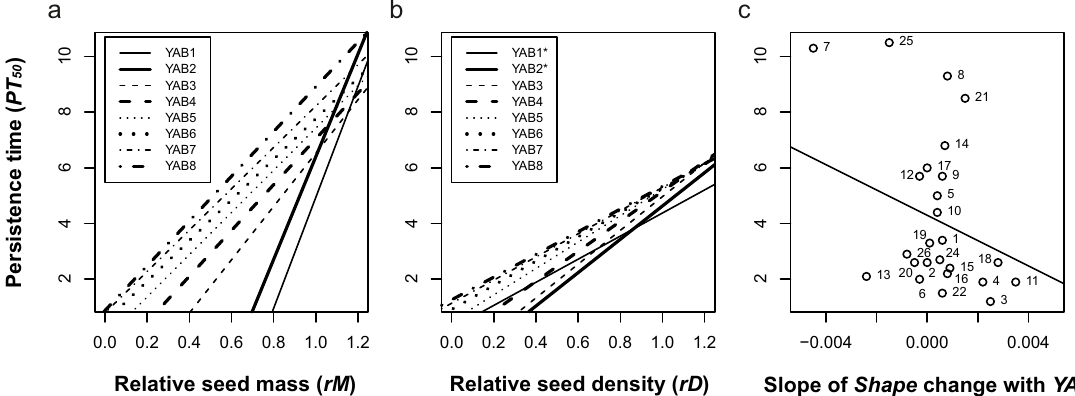
Figure 5. E ff ects of changes in selected morphological seed traits in particular cohorts on PT 50 . ( a ) Relative seed mass (only regression slopes are shown); ( b ) Relative seed density (only regression slopes are shown; * slopes not significantly di ff erent from 0); ( c ) Slope of change in seed shape over years after burial ( YAB ). Symbols indicate seed species, for species codes, see Table